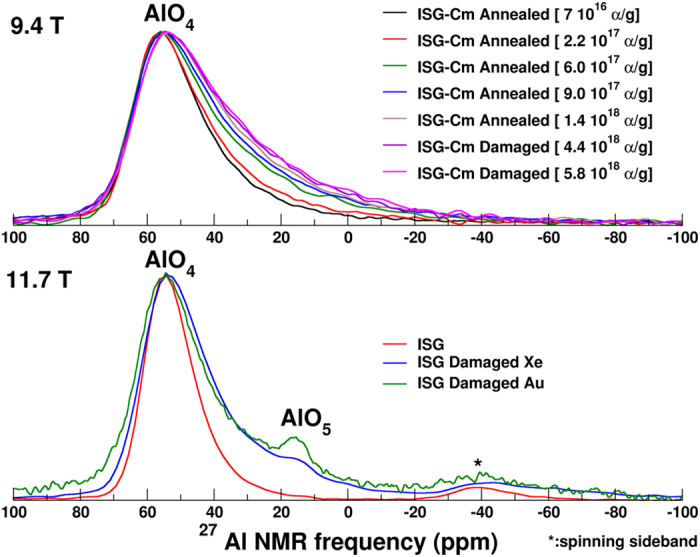
Upper Panel: 27Al MAS NMR spectra of the ISG-Cm glasses (9.4T). Lower Panel: 27Al MAS NMR spectra of the ISG and ISG-damaged Xe (92MeV) and Au (1–7MeV) irradiation from67 (11.7T). Spectra have been normalized to the same height.